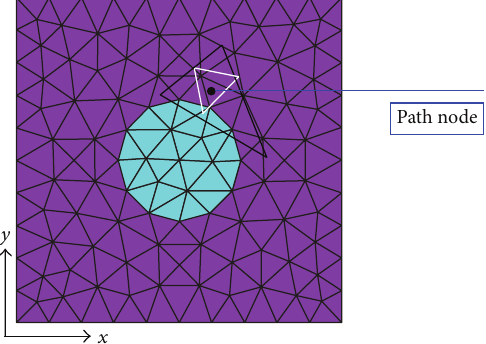
Figure 11: Selection and definition of element